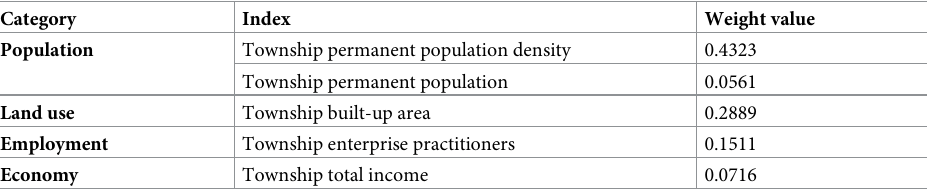
Table 1. Weight value of the indicators of small towns in the Jilin